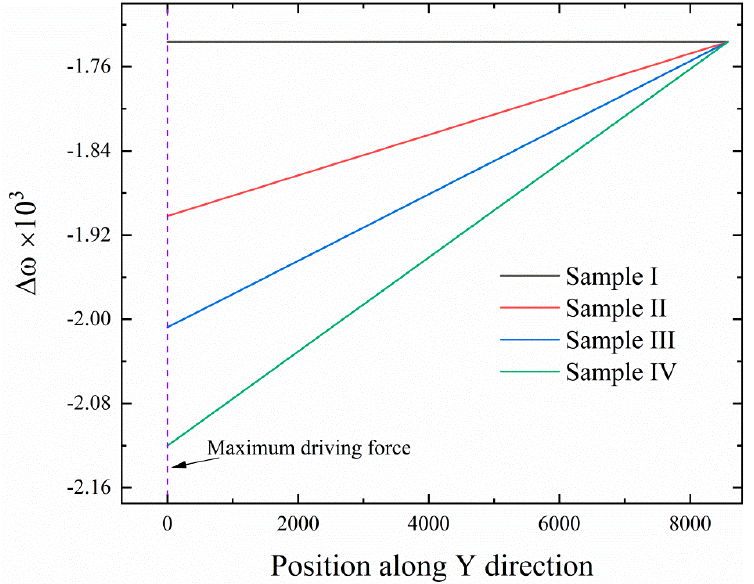
Figure 13. The driving force for the crystallization in sample I–IV under different supergravity strengths. The purple dotted line marks the location of the maximum driving force.